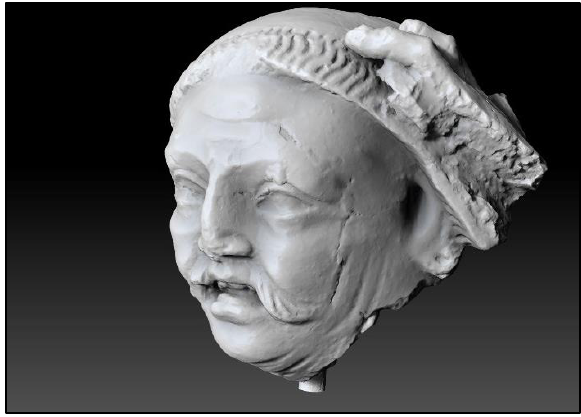
Figure 11. Data captured reconstruction of clay-fired head